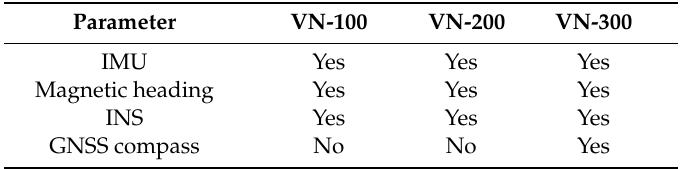
Table 3. Basic functions of Inertial Navigation System (INS) / Global Navigation Satellite Systems (GNSS) of the VectorNav